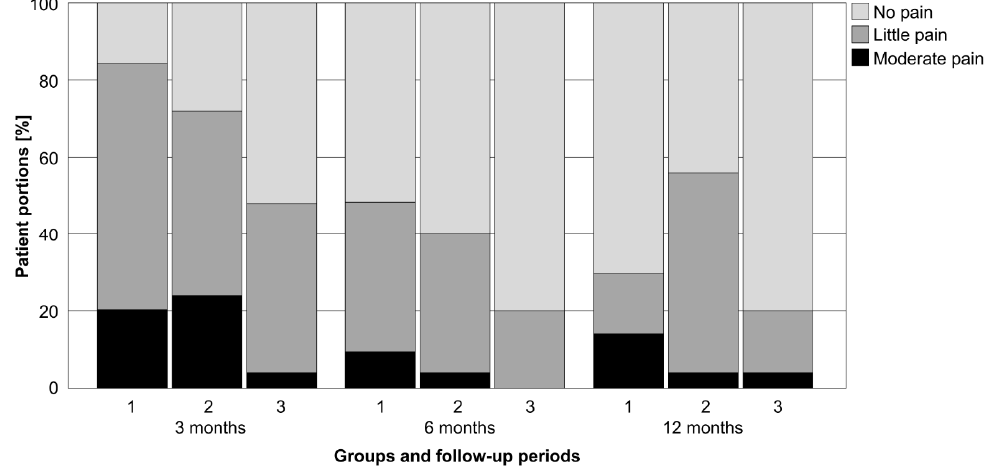
Figure 2. Normalized distribution of patient proportions across treatment groups (1—non-augmen- Figure 2. tation, 2—bone graft augmentation, 3—PMMA augmentation) and follow-up periods (3, 6 and 12 months) regarding self-reported pain levels for no, little or moderate pain.